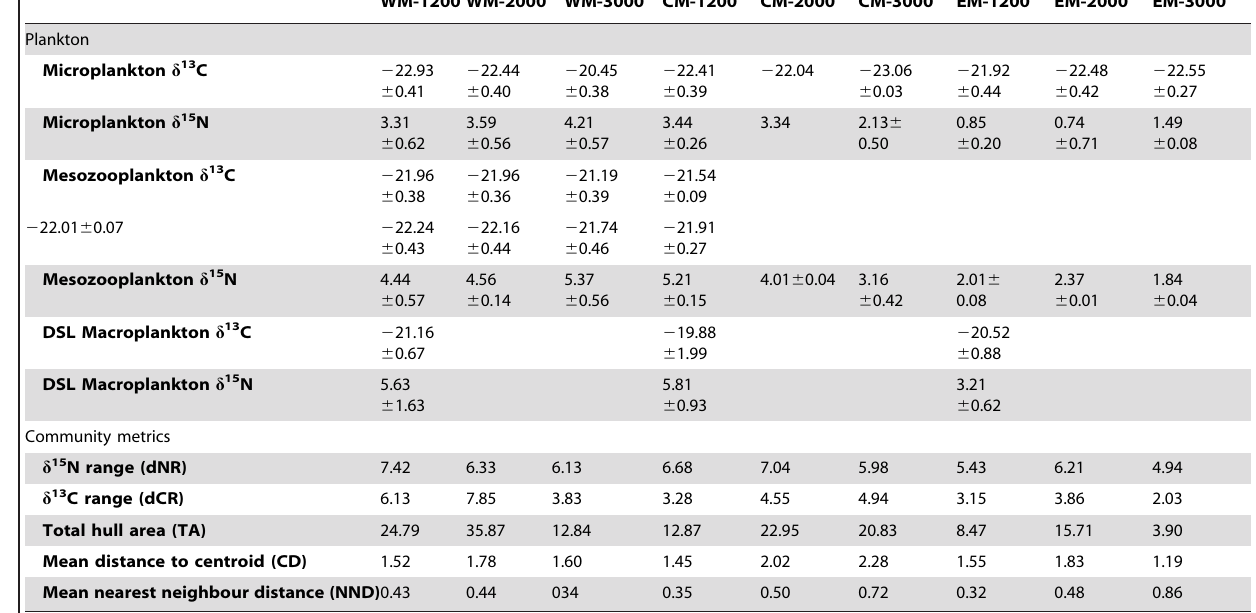
Table 1. Isotopic parameters for pelagic and benthic